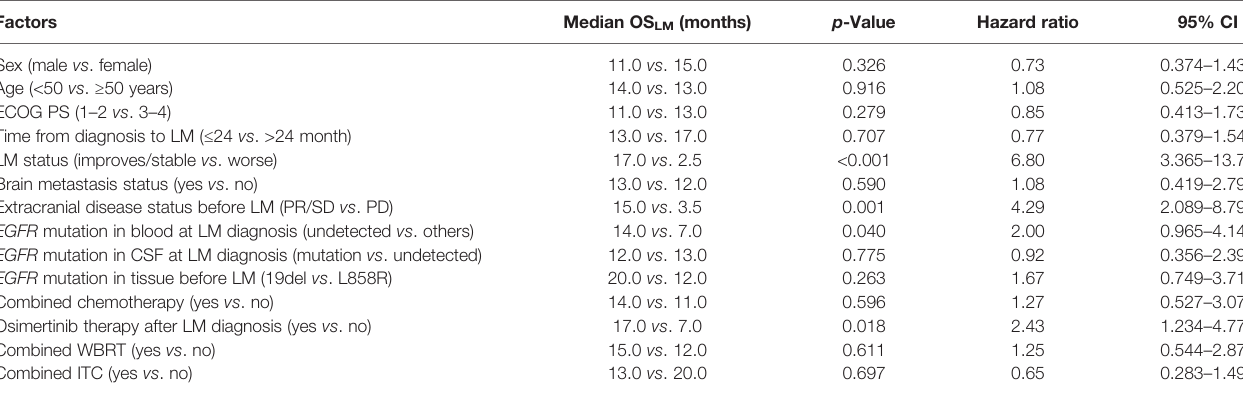
TABLE 3 | Cox proportional hazard model of factors affecting overall